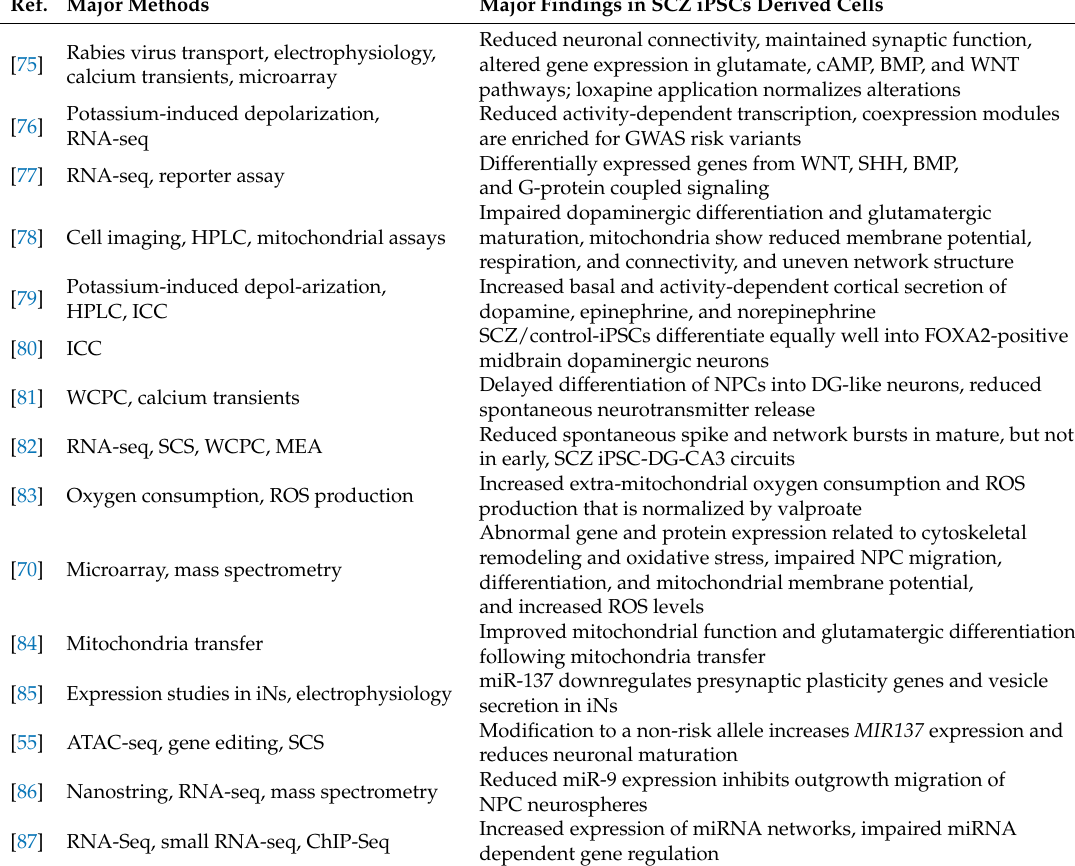
Table 4. Major analytical methods and findings in iPSC-based case/control studies in